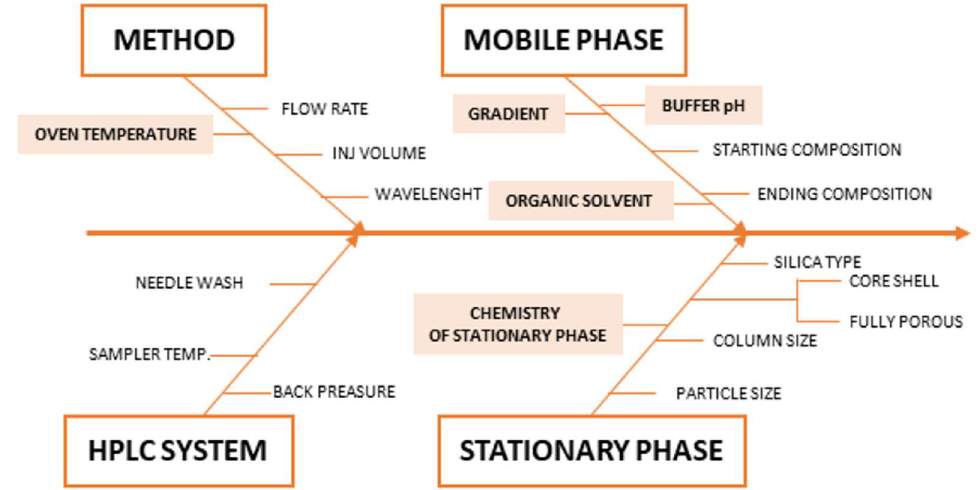
Figure 3. Ishikawa diagram for critical method parameters (CMP) .